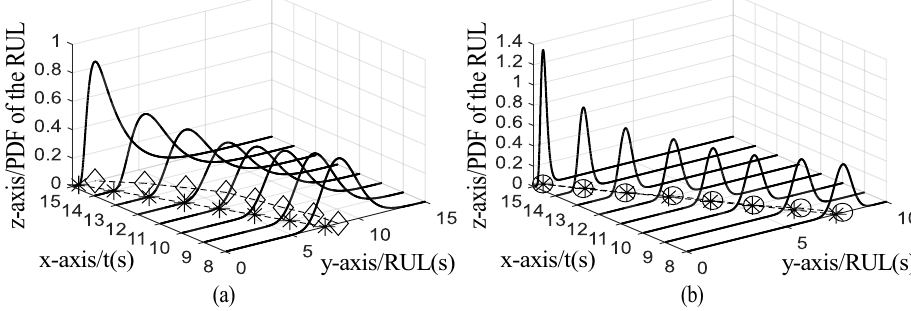
Figure 9. Predicted PDFs of RULs: ( a ) PDF of RUL obtained by standard Wiener process. ( b ) PDF of RUL obtained by improved Wiener process. (“ ♦ ”: predicted mean RUL by standard Wiener process; “ ∗ ”: actual RUL; “ (cid:13) ”: predicted mean RUL by improved Wiener process).